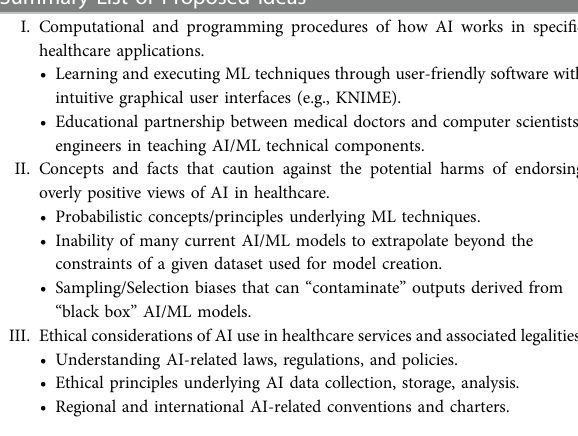
TABLE 1 Key considerations for an AI-oriented medical